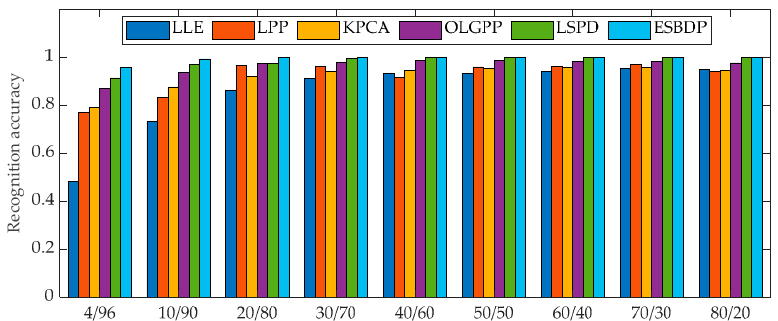
Figure 9. Recognition accuracy under sample variation.